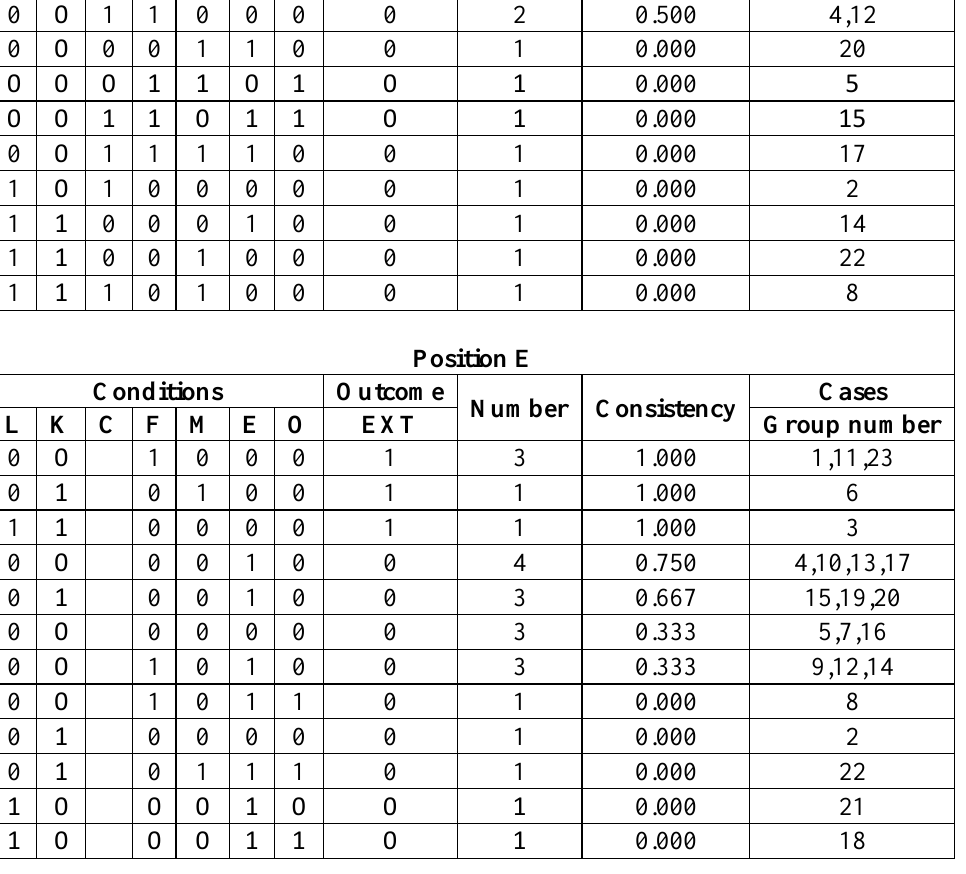
Table A3.7. Results of the csQCA for the analysis of necessity for the group success.